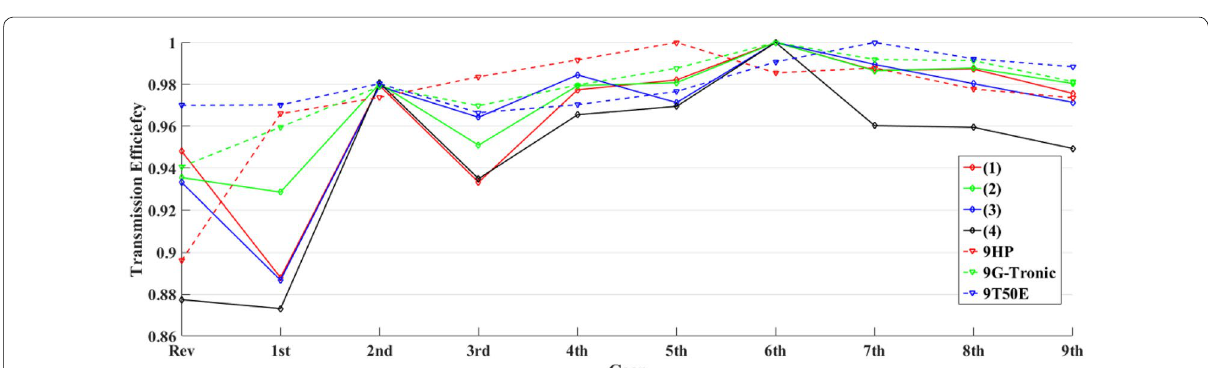
Figure 20 Comparative analysis of the transmission efficiencies of the seven AT